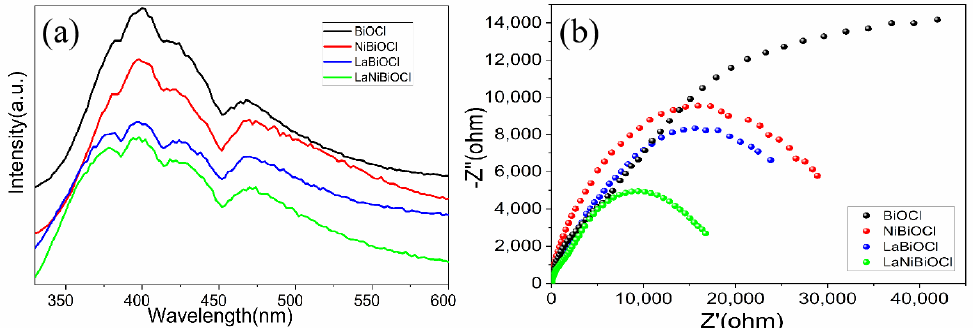
Figure 6. PL spectra ( a ) λ ex = 310 nm and EIS ( b ) of as-prepared samples.